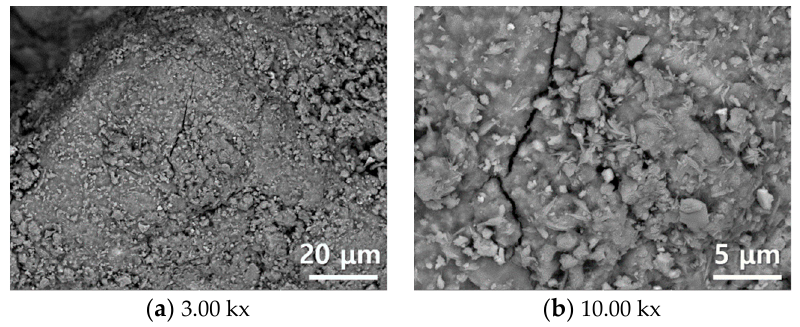
Figure 6. SEM image of as received converter slag.